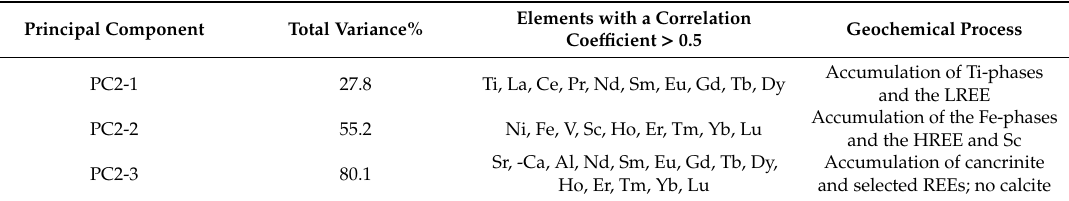
Table 3. Results of the first principal component analysis